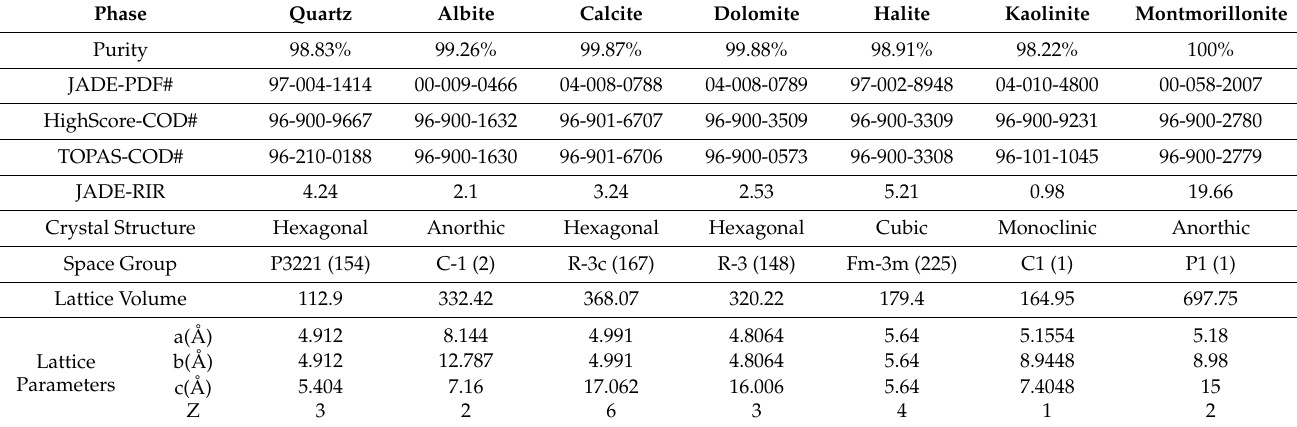
Table 1. The crystal structure parameters of selected